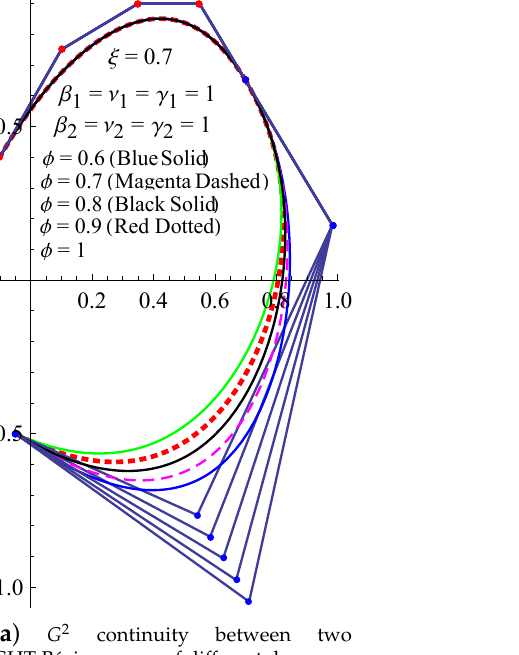
Figure 11. Geometric continuity between two GHT-Bézier curves of different degrees. ( a ) G 2 continuity between two GHT-Bézier curves of different degrees; ( b ) G 3 continuity between two GHT-Bézier curves of different